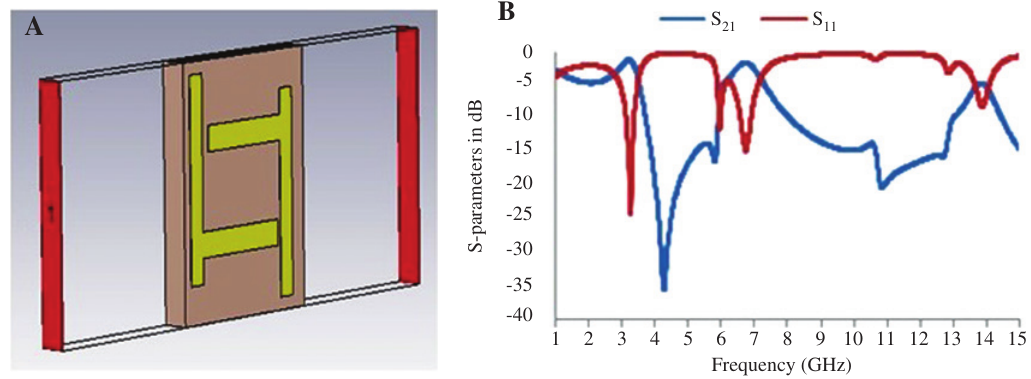
Figure 8: (A) Simulation geometry for y -axis wave propagation and (B) S-parameters (reflection and transmission coefficient) of the proposed unit cell structure for y -axis wave